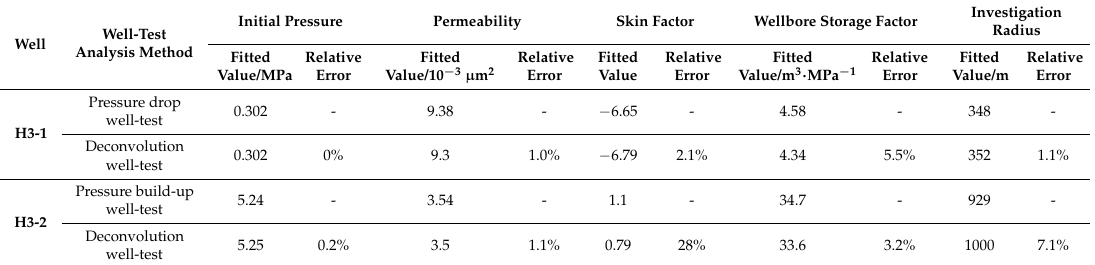
Table 1. The interpretation results of conventional well-test and deconvolution